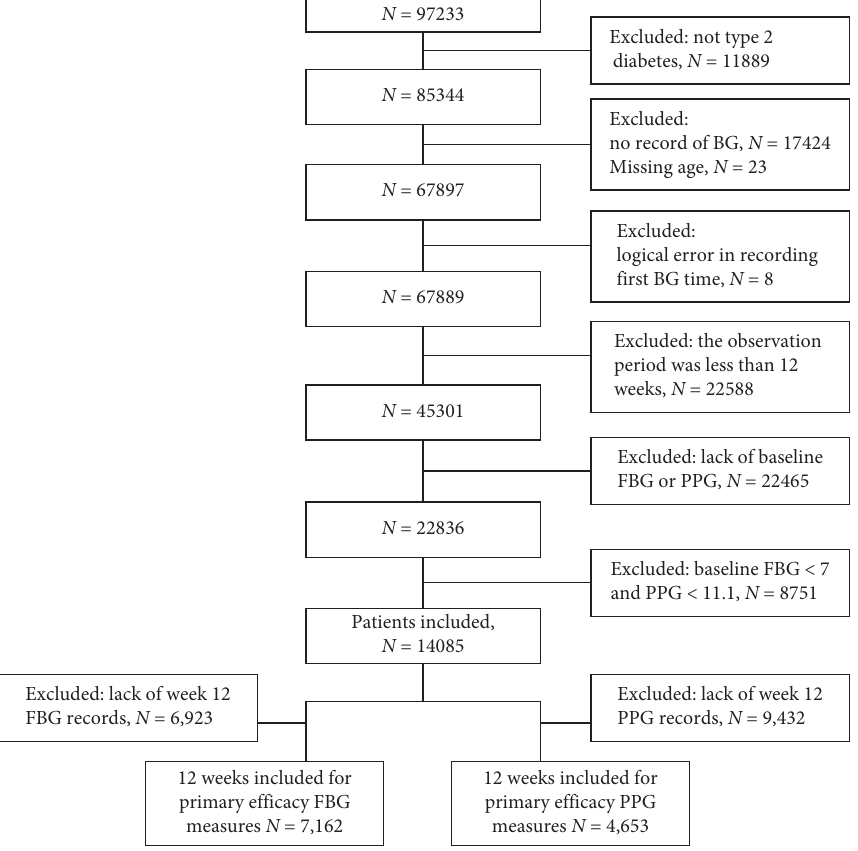
Figure 1: Flow chart of patient